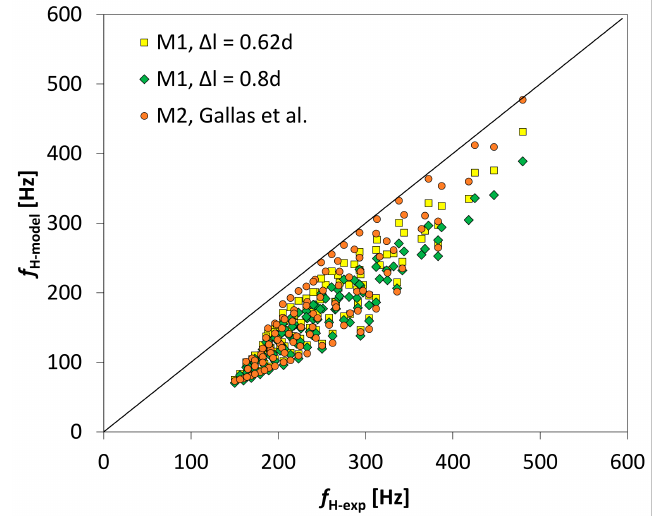
Figure 10. The comparison of Helmholtz resonance frequencies obtained from experiments and models: Equations (5) and (11).